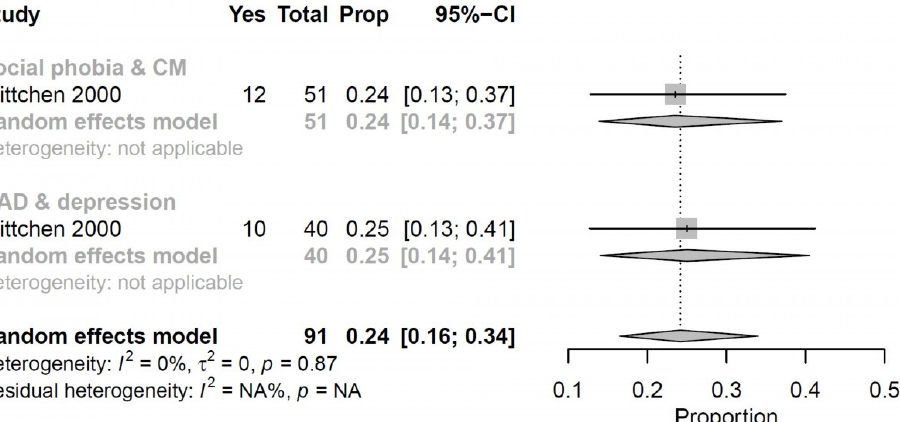
Figure 3. Forest plot shows the percentage of middle-aged persons with multimorbidity that in the past month had worked at least 50% less than those that were not multimorbid.